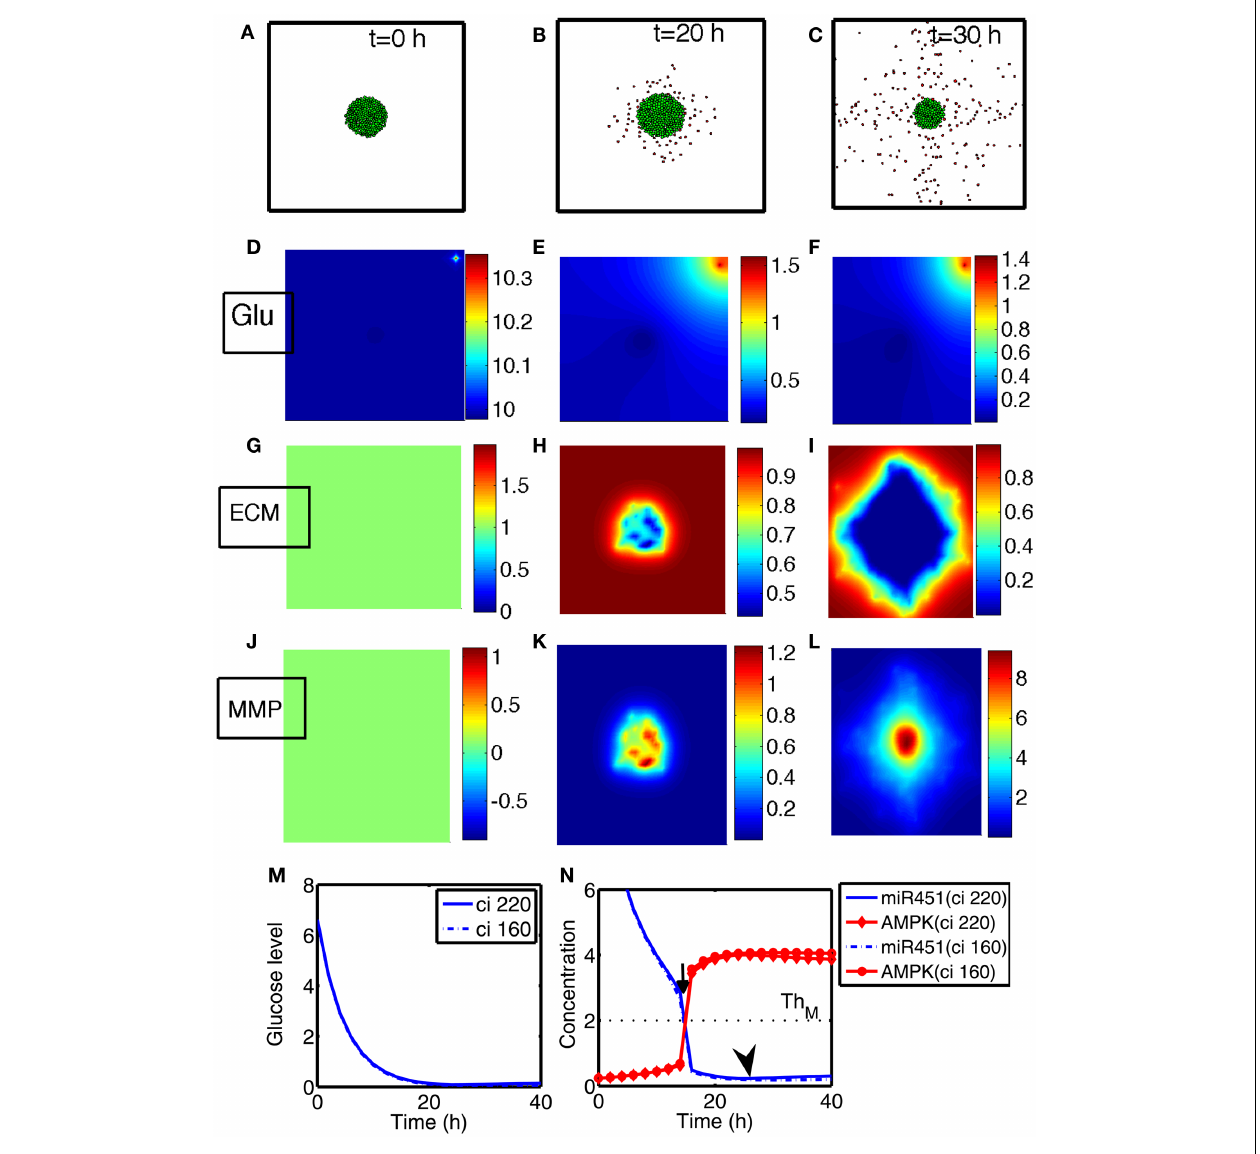
0 . 75] ⊂ [0, 1] 2 . ECM were degraded in the invasive region. (J–L) Profiles of MMPs on the subdomain [0 . 25, 0 . 75] × [0 . 25, 0 . 75] ⊂ [0, 1] 2 . MMPs are localized in tumor region. (M) Glucose levels at two cell sites (cell id = 220, 160). (N) Concentrations of intracellular variables, miR-451 and AMPK complex, at the cell sites in (M)